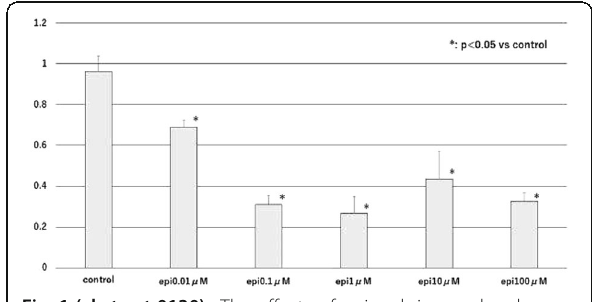
Fig. 1 (abstract 0130) . The effects of epinephrine on basal TNF- α